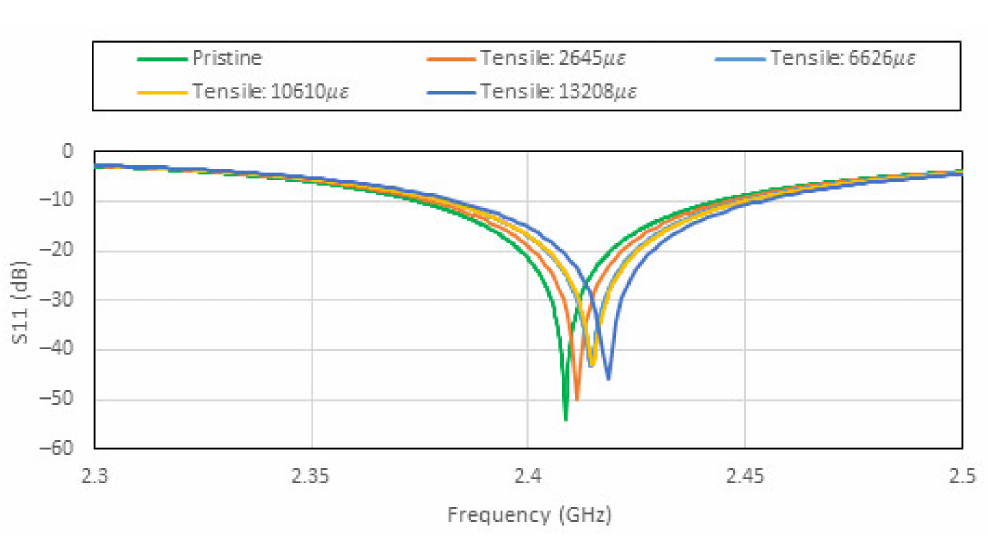
Figure 8. Effects of tensile loading on the patch antenna’s S11 plotted against